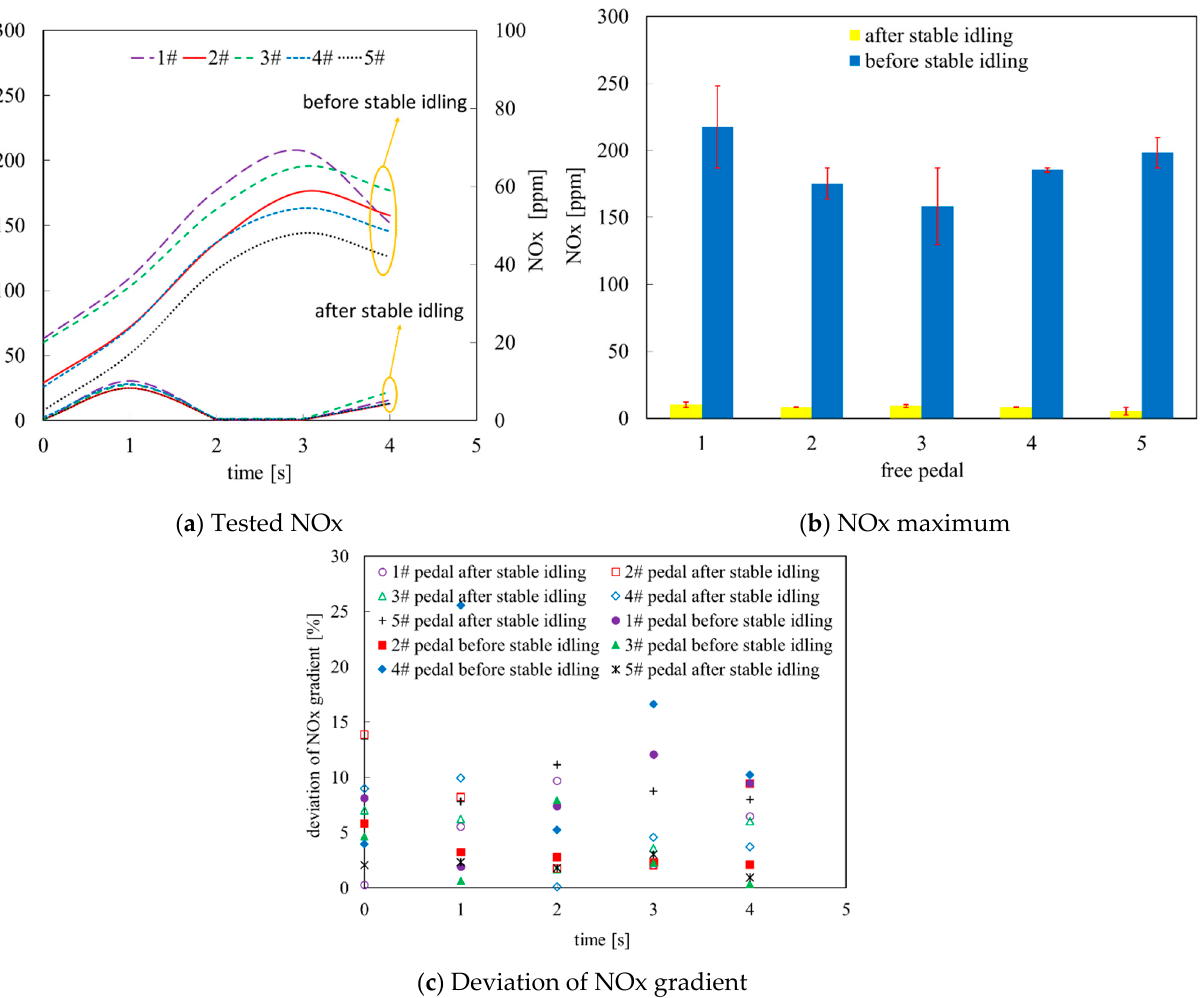
Figure 3. Test deviation analysis.